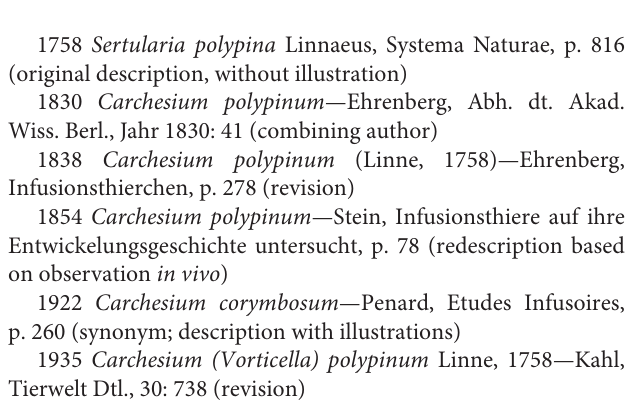
The colony was up to 750 µ m tall, usually with fewer than 20 zooids. The stalk was dichotomously branched. The spasmoneme is discontinuous and extends throughout the colony ( Figures 8D , 9A